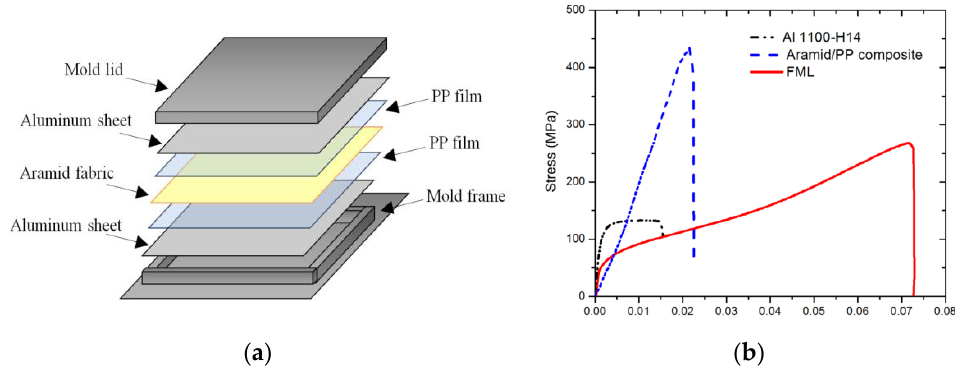
Figure 12. ( a ) The structure of Al-PP–aramid composite and ( b ) a comparison of the flow curves of the Al, composite core, and FML material (adapted with permission from Ref. [97], Copyright 2017 Elsevier